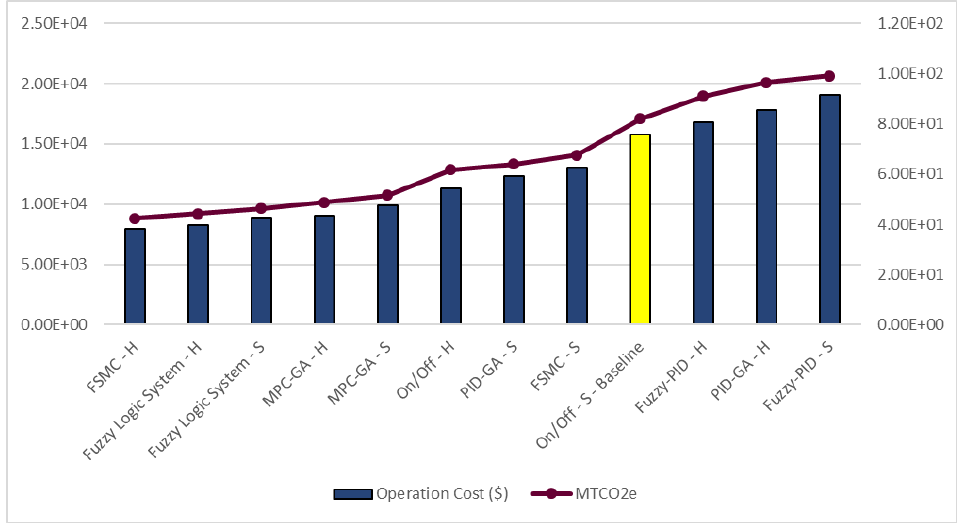
Figure 13. Operational Cost (left vertical axis) and CO 2 emission (right vertical axis) of applying different control algorithms in steam (S) and hydronic (H) system.